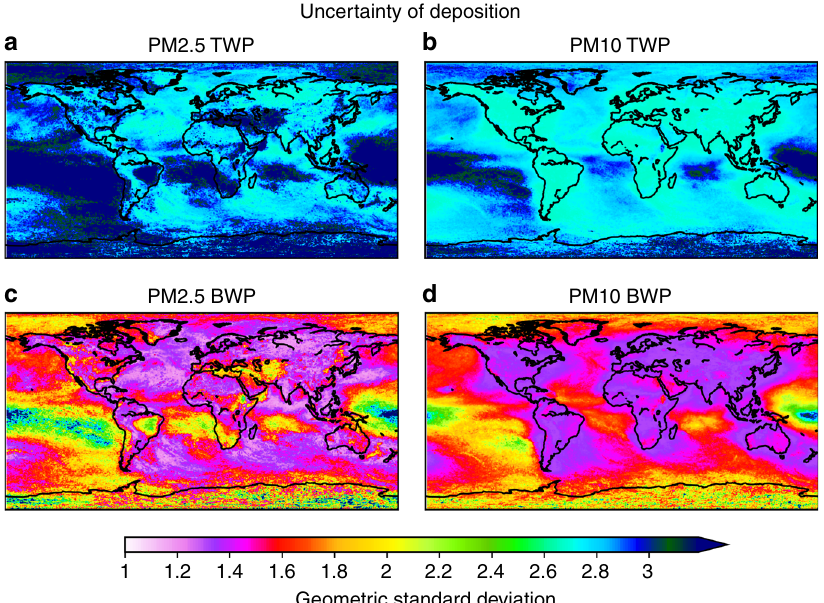
Fig. 4 Model uncertainty. Calculated model uncertainties of deposition. Uncertainties were calculated from a model ensemble of 120 members for each of the PM2.5 and PM10 sizes, both for tyre wear particles (TWPs) and brake wear particles (BWPs). The ensemble accounts for ( a ) airborne PM10 TWP fraction to be 2.5, 5, 10, 20 and 40% of the total TWP emissions, ( b ) PM2.5 TWP to be 0.25, 0.5, 1, 2 and 4% of the total TWP emissions, while ( c ) PM2.5 BWP fraction was assumed to be 30, 40, 50, 60 and 70% of total BWPs and ( d ) PM10 BWP fraction of 60, 70, 80, 90 and 100% of the total BWPs, different wet scavenging coef fi cients that de fi ne CCN/IN (cloud condensation nuclei/ice nuclei) ef fi ciency, and different assumptions on the airborne fraction in the emissions (see “ Methods ” ). Uncertainties are given as the geometric standard deviations, since sensitivity scenarios followed a largely log- normal distribution (see “ Methods ”